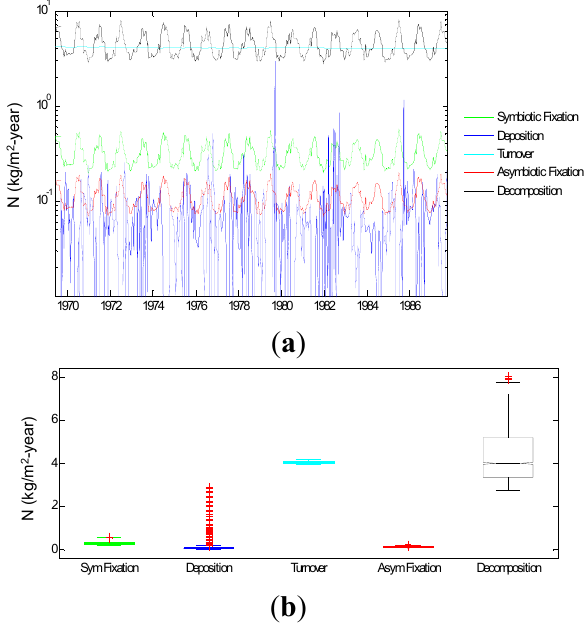
Figure 6. Key modeled rate terms associated with carbon cycling. ( a ) The plot represents the modeled time series, as indicated in the legend, across the 20 year simulation time frame. These data are summarized and presented as a box and whisker plot ( b ). Note that the y axis is log transformed in the upper plot, but is linear in the lower plot. The combination is provided to more clearly outline the range in variation.